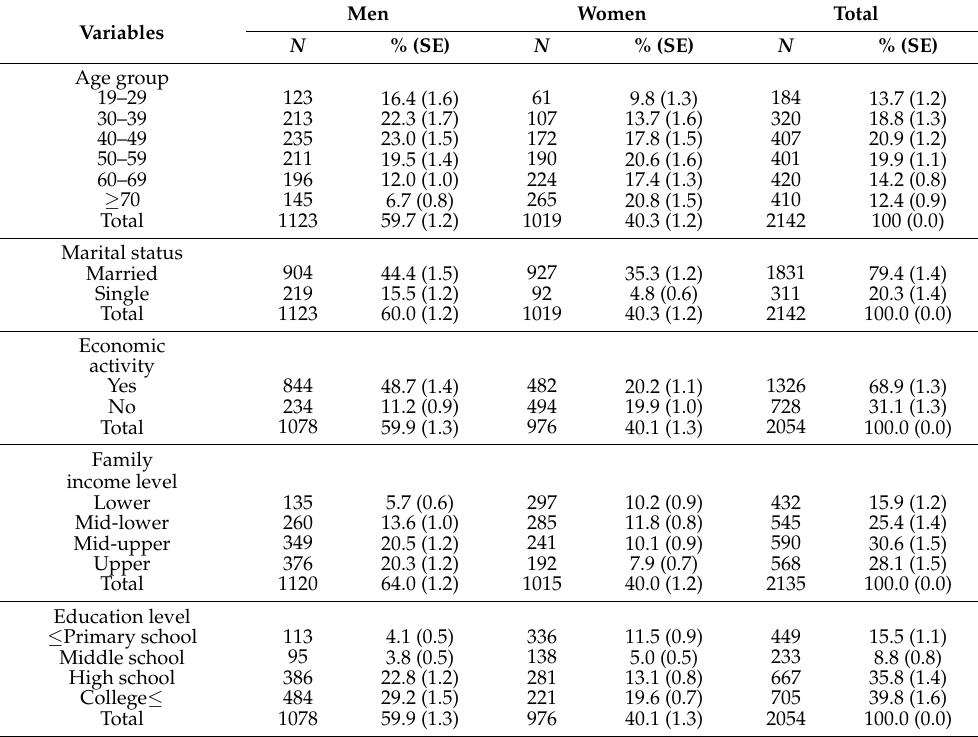
Table 2. Demographic characteristics in Korean obese (25 ≤ BMI) population (age ≥ 19 years